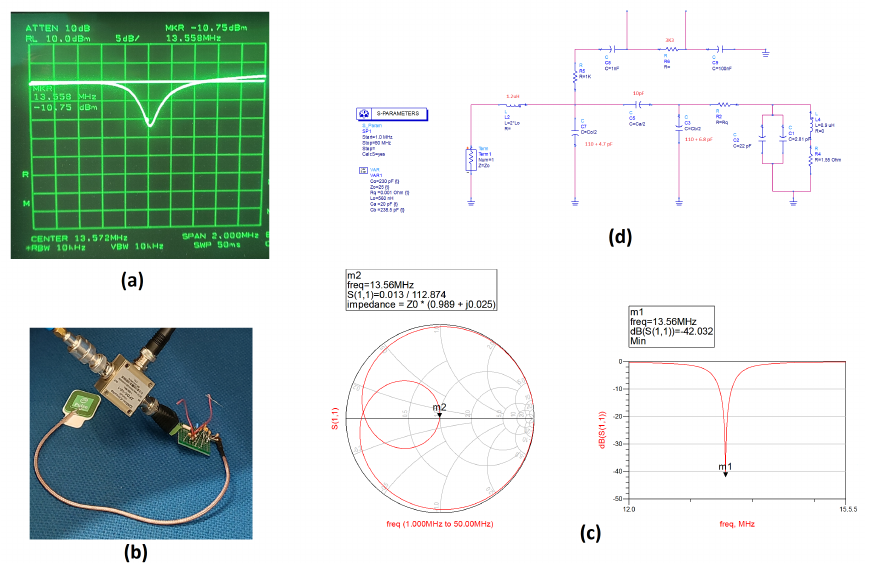
Figure 2. ( a ) Measured return loss of the antenna with the matching circuit. ( b ) NFC antenna and matching circuit test fixture. ( c ) Simulated impedance seen at the input of the matching circuit and return loss. ( d ) Equivalent circuit of the matching network and the antenna.